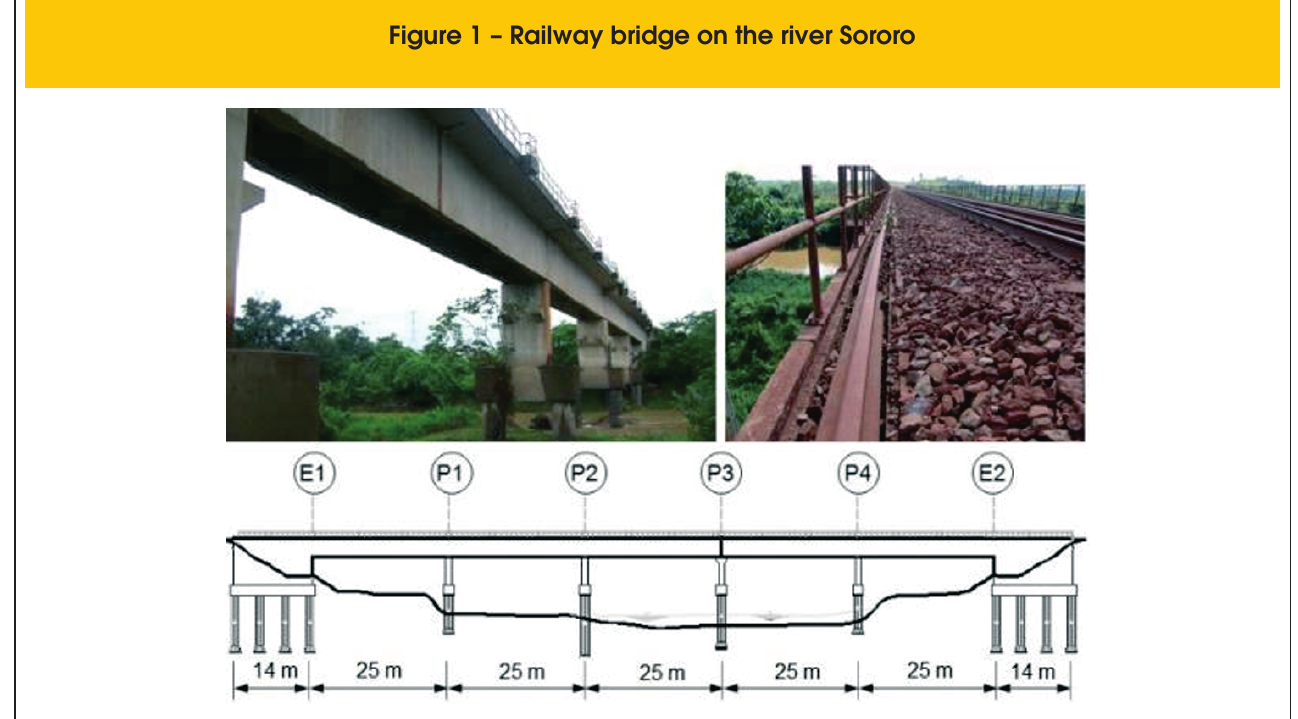
Figure 1 – Railway bridge on the river